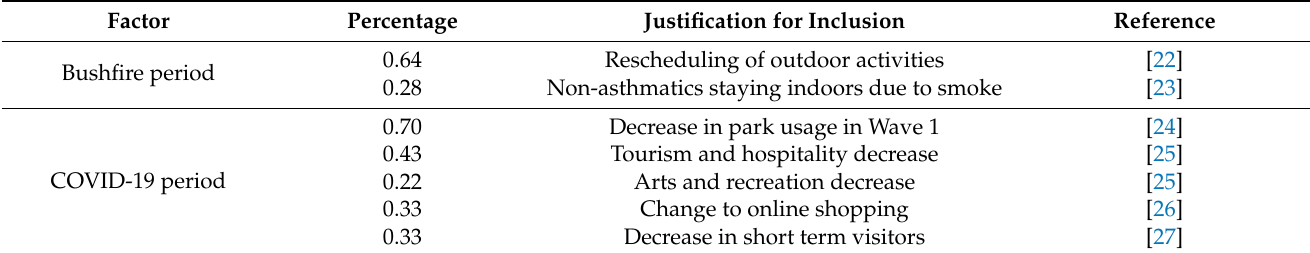
Table 1. Literature and data used to determine outdoor activity behaviour change. Factor